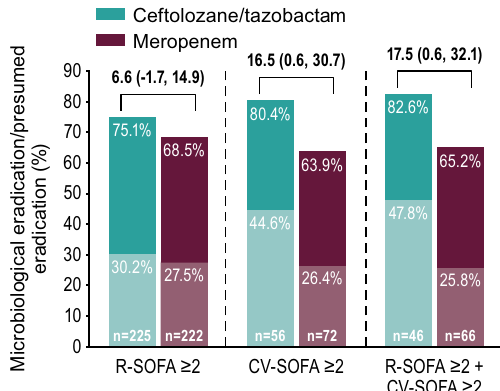
Fig. 5 Microbiologic eradication/presumed eradication at TOC by SOFA component score (mITT population). Observed microbiologic eradication is represented by the lighter colored bars; presumed eradication is represented by the darker colored bars. Treatment differences were calculated as unstratified Newcombe 95% CIs; positive differences are in favor of ceftolozane/tazobactam; negative differences are in favor of meropenem. Participants with missing culture and clinical responses that were failure, indeterminate, or missing were counted as presumed failures. CI confidence interval, CV-SOFA cardiovascular SOFA component score, R-SOFA respiratory SOFA component score, SOFA Sequential Organ Failure Assessment, TOC